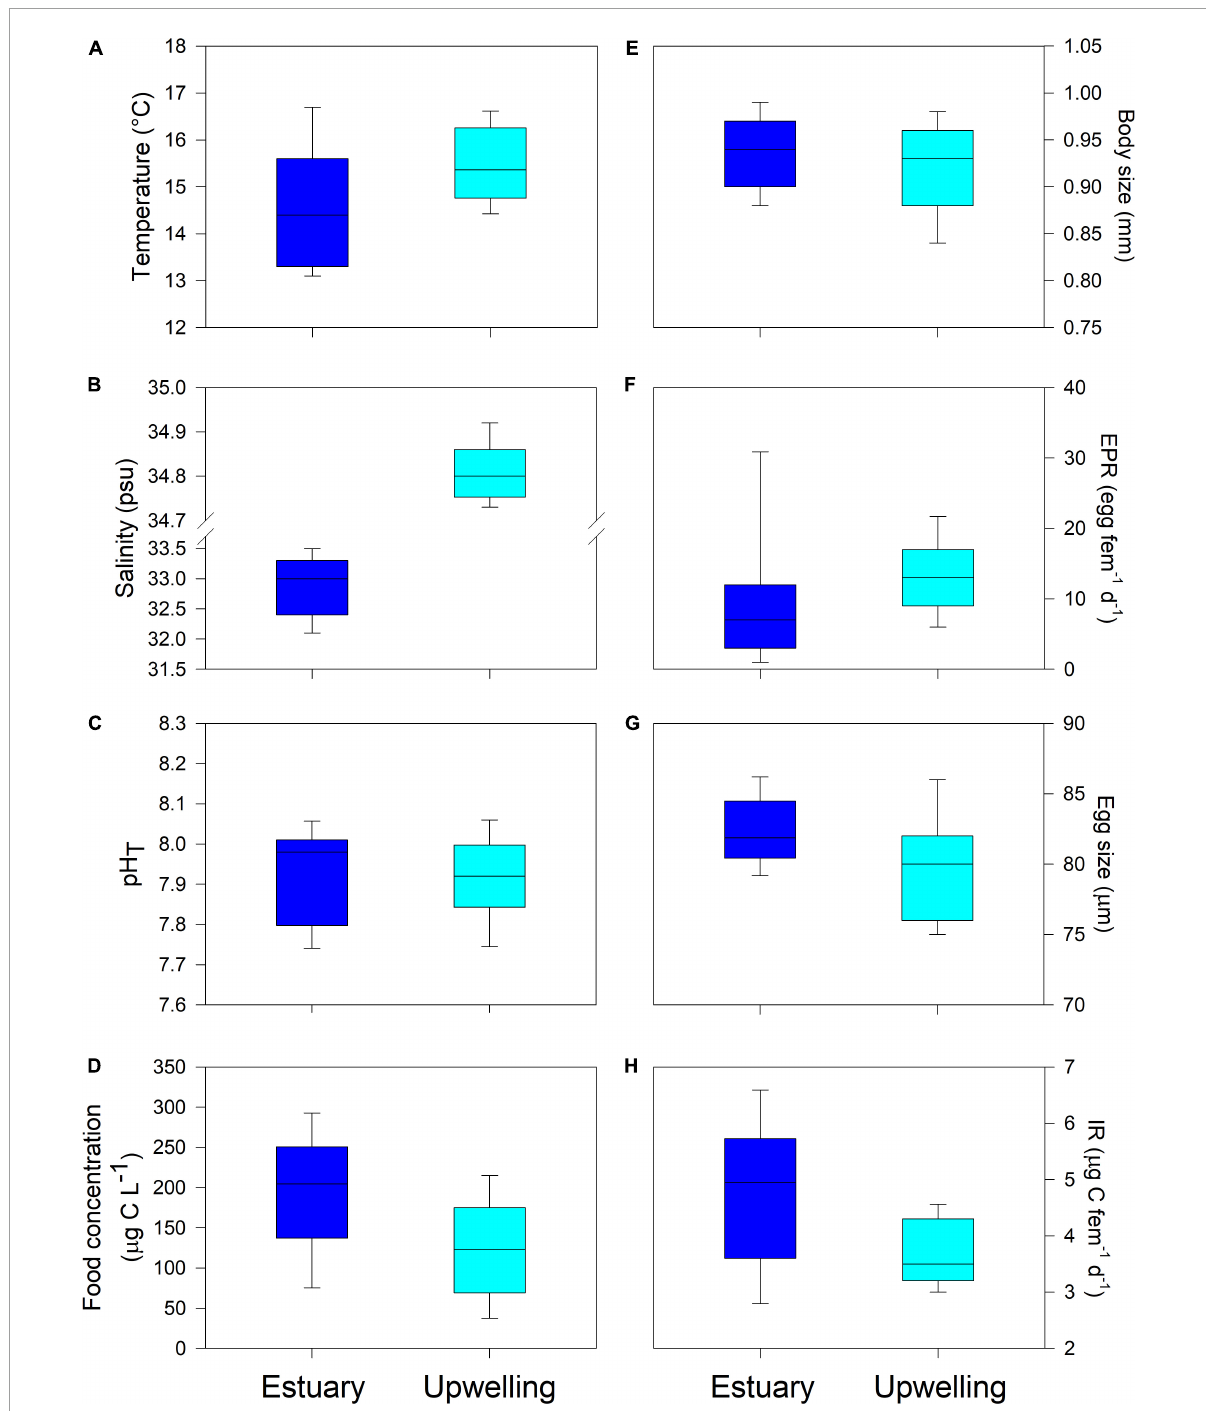
FIGURE4 Comparison of box plots of environmental drivers (A–D) and copepod traits (E–H) between examined estuarine and upwelling populations. Statistical results are provided in Table 2 .